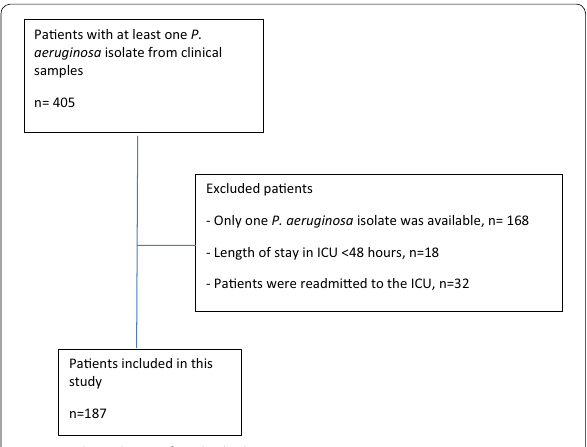
Fig. 1 Flowchart of included patients